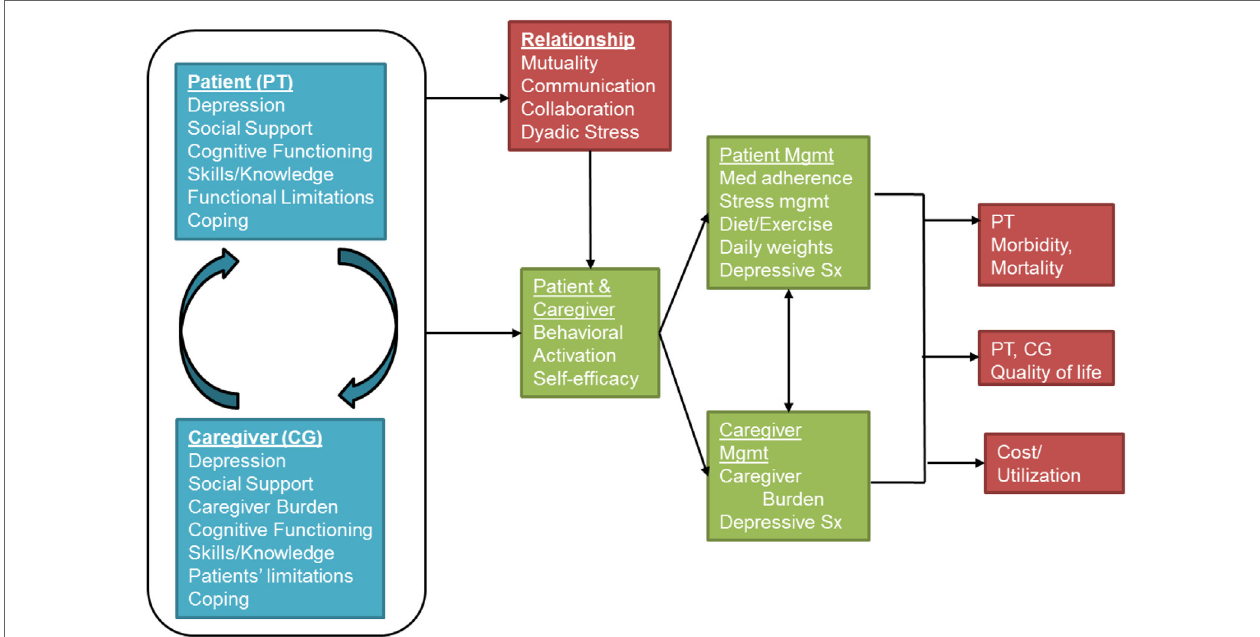
FigUre 1 | The Dyadic health Behavior change Model